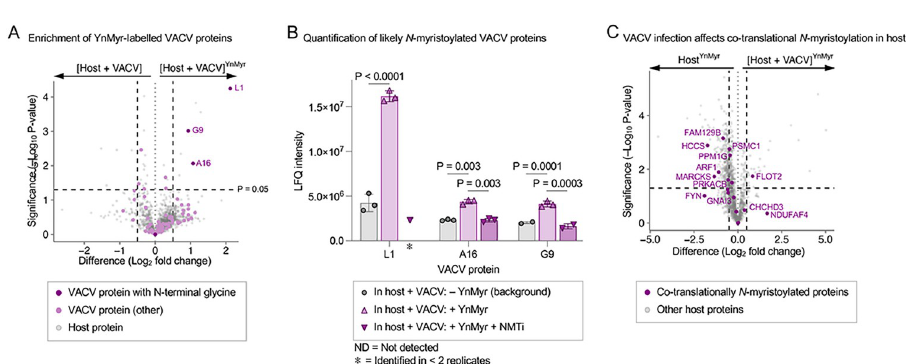
Fig 2. Chemical proteomic identification and quantification of host and viral proteins after VACV infection, enrichment, and mass spectrometric detection. (A) Identification of VACV proteins after YnMyr enrichment. 3 N - myristoylated VACV proteins depicted in purple, 115 VACV proteins in pink, 2738 human proteins in gray. (B) Label free quantification intensity of N- myristoylated VACV proteins L1, A16, G9, as determined in background, after metabolic tagging with YnMyr and after NMT inhibition with 2 μ M IMP-1088. Average of 3 replicates, error bars depict standard deviation, significance tested by ANOVA. (C) Effect of VACV infection on 32 known co- translationally N- myristoylated protein levels of the host (purple). Other proteins in gray. For volcano plots shown in (A) and (C), the horizontal and vertical axes show the difference in quantified protein levels and the significance of the quantified difference, respectively. The labels above the right and left arrow indicate the two conditions being compared within the plot. The dashed vertical lines depict -0.5 Log 2 and +0.5 fold change; horizontal dashed line depicts significance cut-off (p =